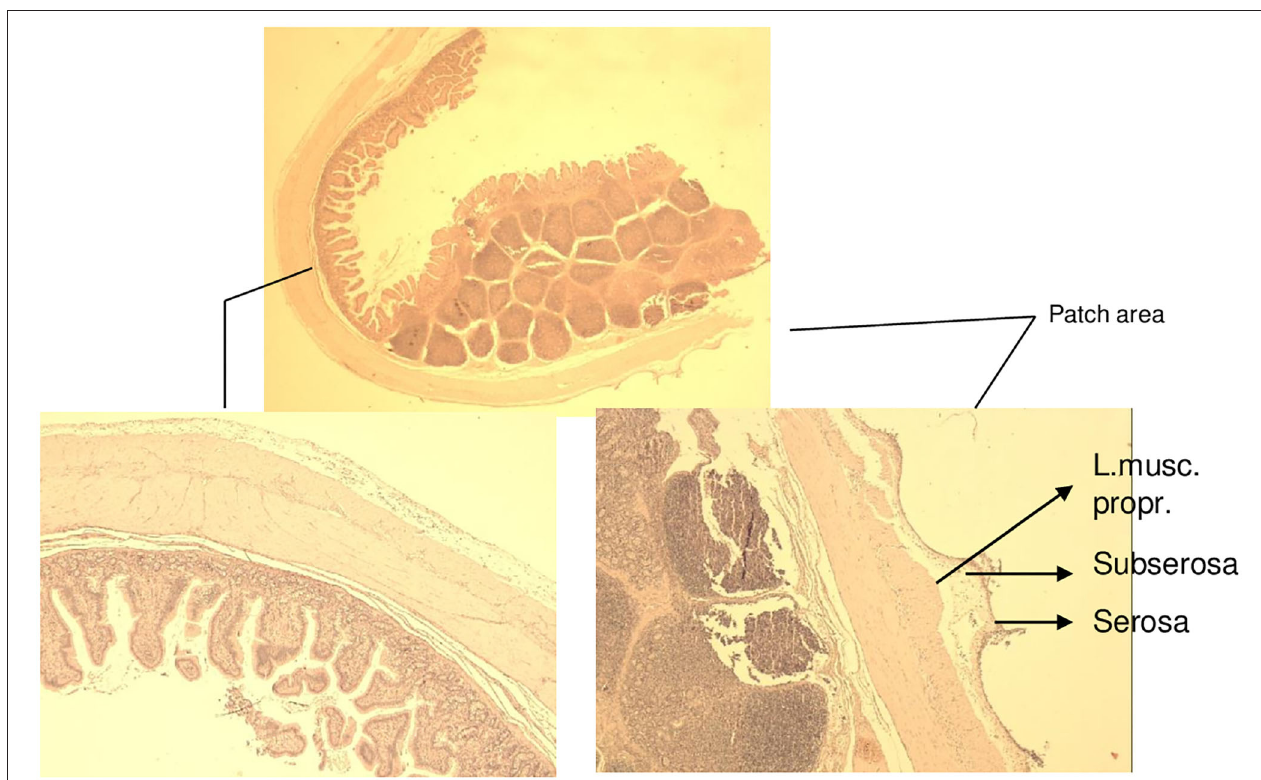
FIGURE 10 | Animal 7, − 60 mmHg. Histology small intestine. Patch to non-patch transition area. In the patch area, lobe-shaped extensions are mainly the serosa and subserosa affect. The lamina muscularis propria is only minimally involved. Smooth non-patch area surface.